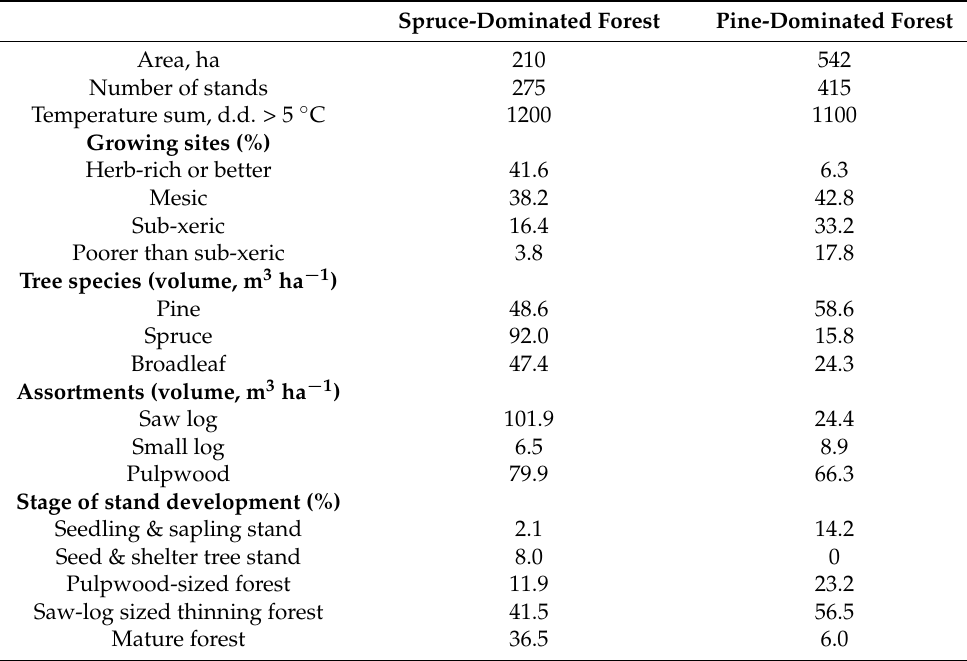
Table 1. The characteristics of two case study forest